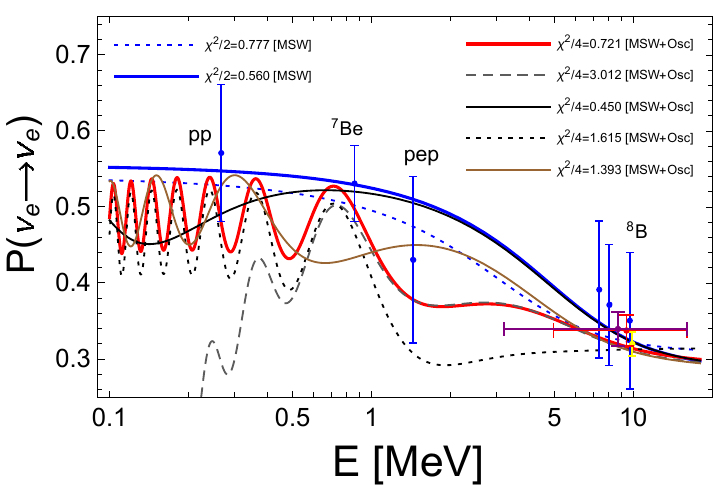
Figure 4 . Plot of χ 2 -fitting the model function of eq. (4.29) to a set of data.